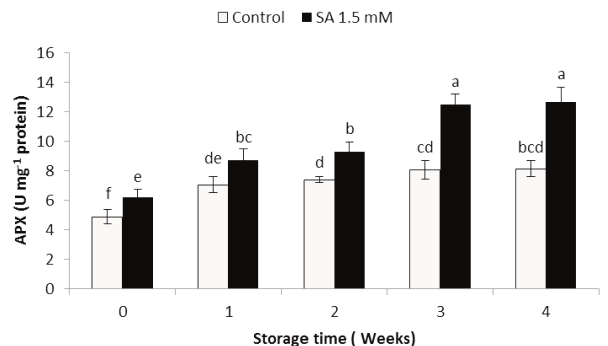
Fig. 10 -APX activity of peach fruits treated with preharvest SA at 1.5 mM stored at 1±0.5°C for up to 28 days. Data shown are mean ± standard deviation of three replicate (n =